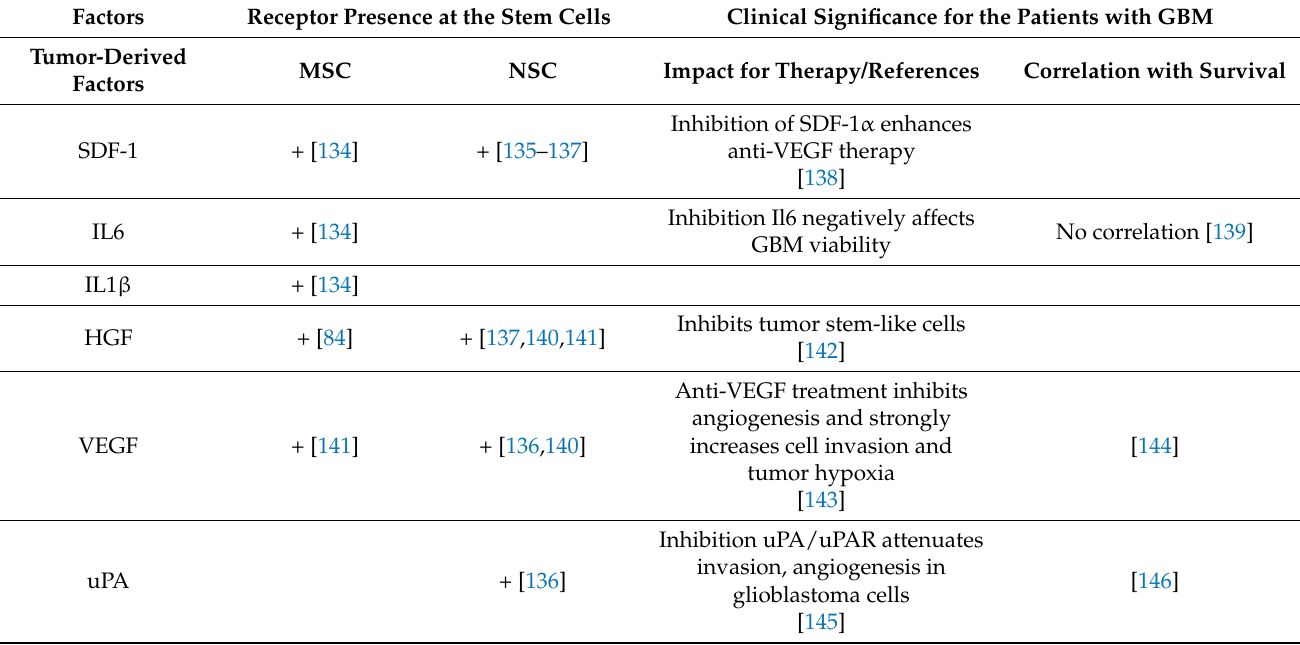
Table 2. Growth factors expressed in glioblastoma and their roles in therapy and patient